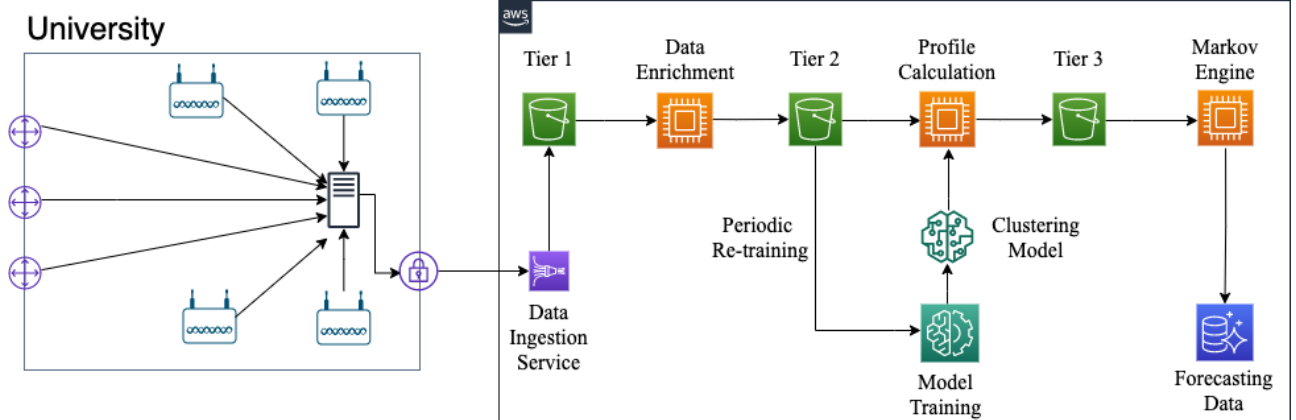
Figure 1. Diagram of the proposed strategy for users’ profile identification and load forecasting on the network. Data are de-identified in the central server at the University, and the de-identified data are processed in the AWS cloud